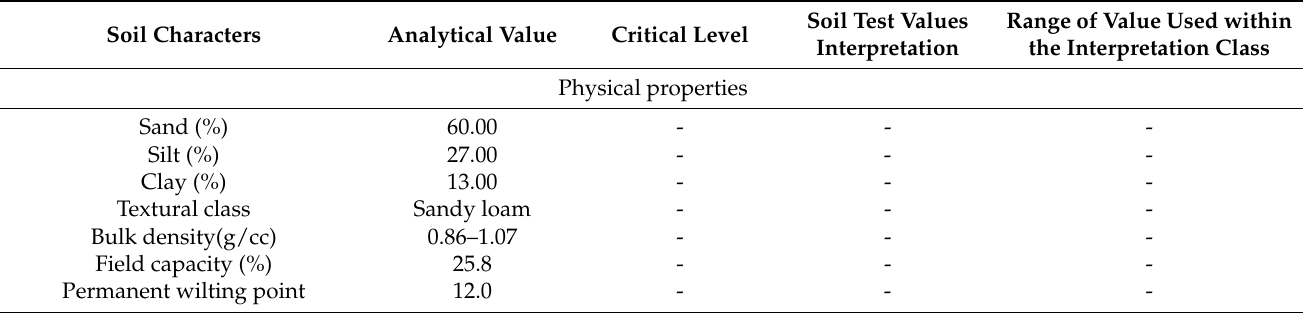
Table 2. Initial soil physical and chemical properties of experimental fields and their interpretation according to fertilizer recommendation guide